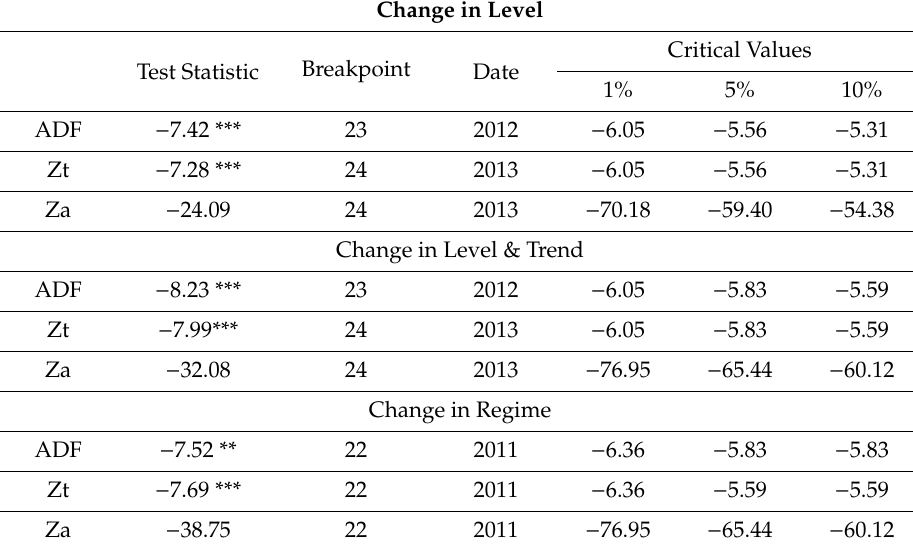
Table 7. Gregory–Hansen test for co-integration with regime shifts